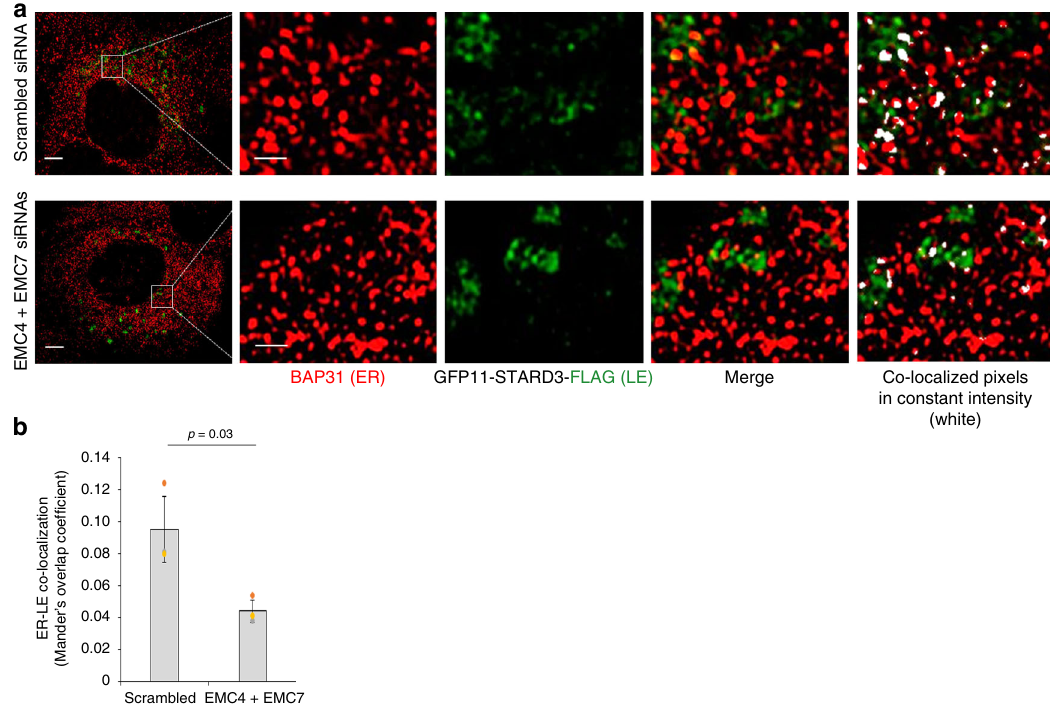
Fig. 5 EMC4 and EMC7 support colocalization of the ER and LE. a GFP11-STARD3-FLAG-expressing CV-1 cells transfected with scrambled or EMC4 + EMC7 siRNAs were infected with SV40, fi xed at 5 h post infection, and stained with BAP31 (ER marker) and FLAG (LE marker) antibodies. Cells were analyzed by structured illumination microscopy (SIM). Images with colocalized pixels were generated with FIJI/ImageJ colocalization threshold plugin. Scale bar in the fi rst column = 5 µ m, scale bar in the second column = 1 µ m. b ER-LE colocalization in A was quanti fi ed by the Mander ’ s Overlap Coef fi cient using the FIJI/ImageJ coloc2 plugin. The image analysis was done on a single z-plane. Values represent the mean ± SD from three independent experiments, and at least ten FLAG-expressing cells were analyzed for every condition during each independent experiment. Unpaired Student two-tailed t -test was used to determine statistical signi fi cance. Source data are provided as a Source Data fi